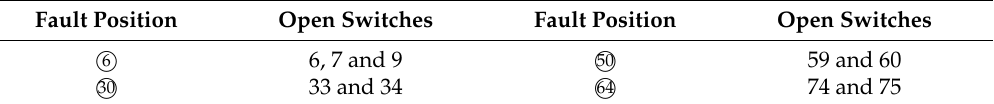
Table 1. Switches to be opened to isolate the faults in sections 6 (cid:13) , 30 (cid:13) , 50 (cid:13) and 64 (cid:13) . Fault Position Open Switches Fault